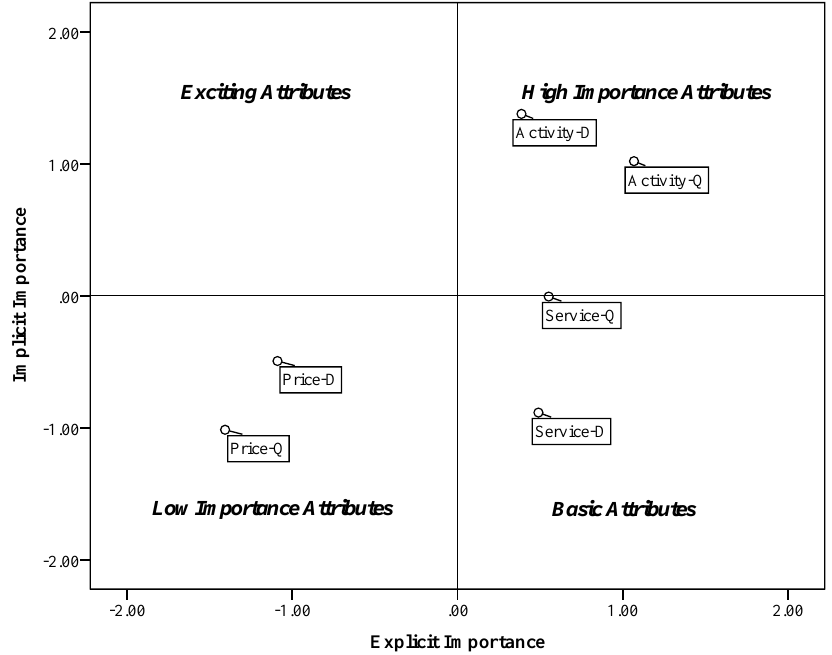
Figure 5. Importance grid for attributes (D: Dalishu scenic spots; Q: Qingshan scenic